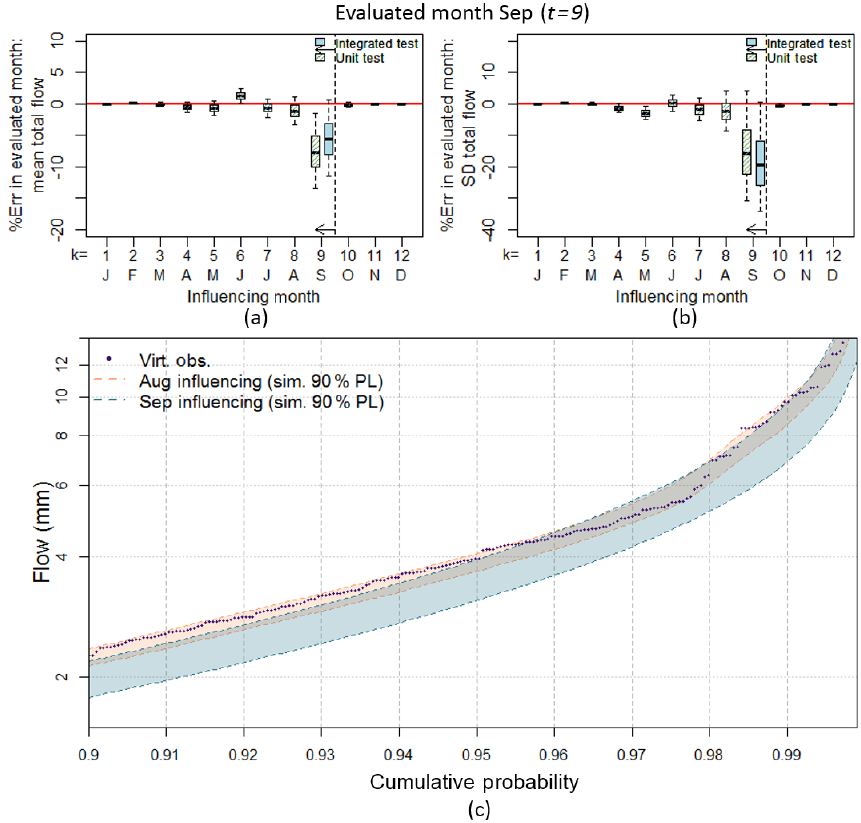
Figure 9. Lobethal, Site 12 (a) unit test error in mean monthly flow (September), (b) unit test error in standard deviation of monthly flow (September), (c) unit test September flow duration curve when August and September are selected as influencing months (top 10% of flow days shown). Boxplot whiskers indicate the 90% limits of the simulated streamflow